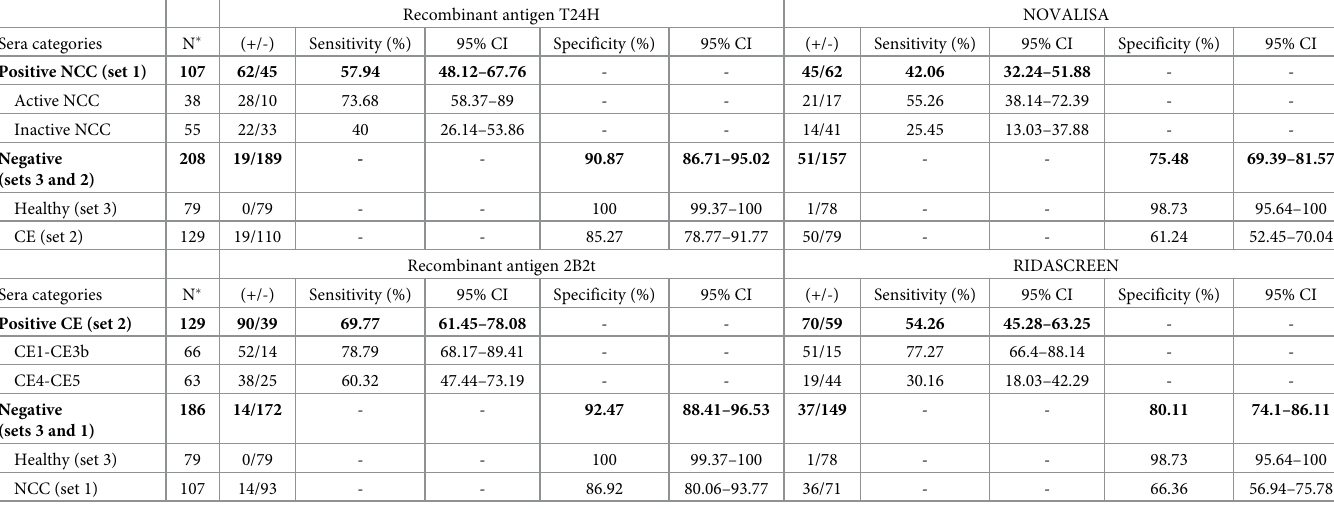
Table 4. Diagnostic accuracy of rT24H- and r2B2t- MBA, and Novalisa, Ridascreen ELISA assays when excluding equivocal ELISA results from the analysis. Recombinant antigen